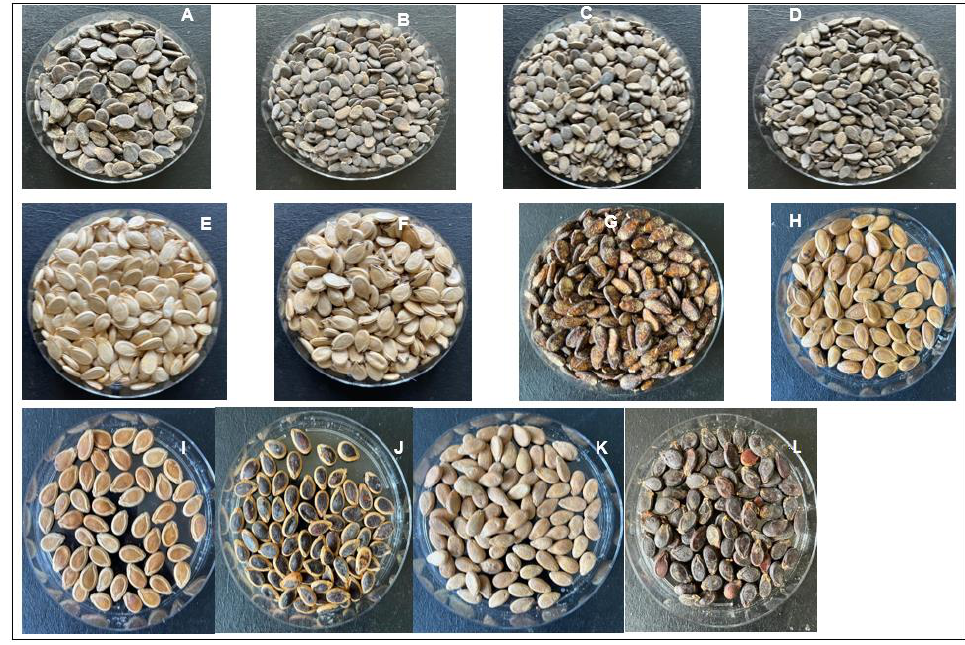
Figure 2. Seed coat colours differences among sweet watermelon accessions. ( A ), Black seed coat colour of sweet watermelon cultivar “Charleston Grey”; ( B ), Black seed coat colour of sweet watermelon “Crimson Sweet”; ( C ), “All Sweet” watermelon variety with black and brown seed coat colour; ( D ), “Sugar Baby” sweet watermelon variety with black seed coat colour; ( E – L ), Sweet watermelon landrace accessions collected from Moletjie Ga-Mphela village in the Limpopo Province of South Africa displaying varied seed coat colours ranging from light-brown/yellow with red eyes ( E ) and black seed eyes ( F ), dark-brown and black seeds ( G ), dark-brown seeds ( H ), dark-brown seed with white seed margins ( I ), black seeds with brown seed margins ( J ), brown seeds ( K ) and maroon seeds ( L ) (Photographs by J. Mashilo).